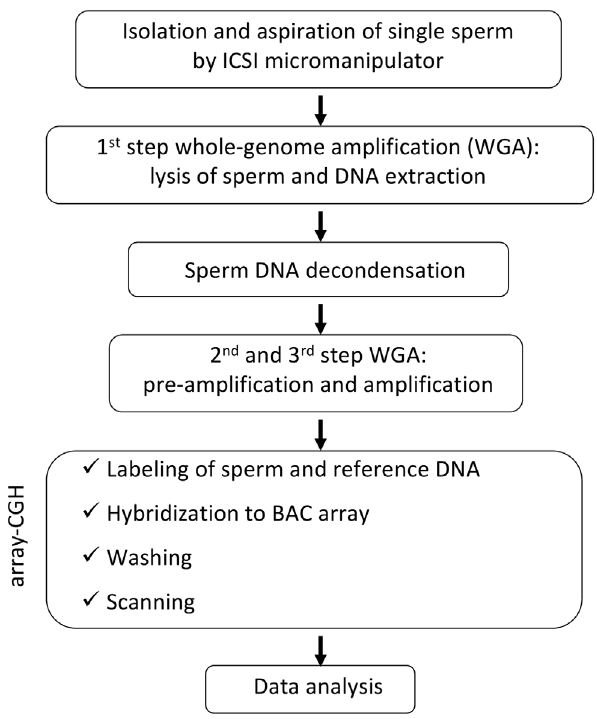
Figure 1. Flow diagram of the protocol developed for aCGH on single human